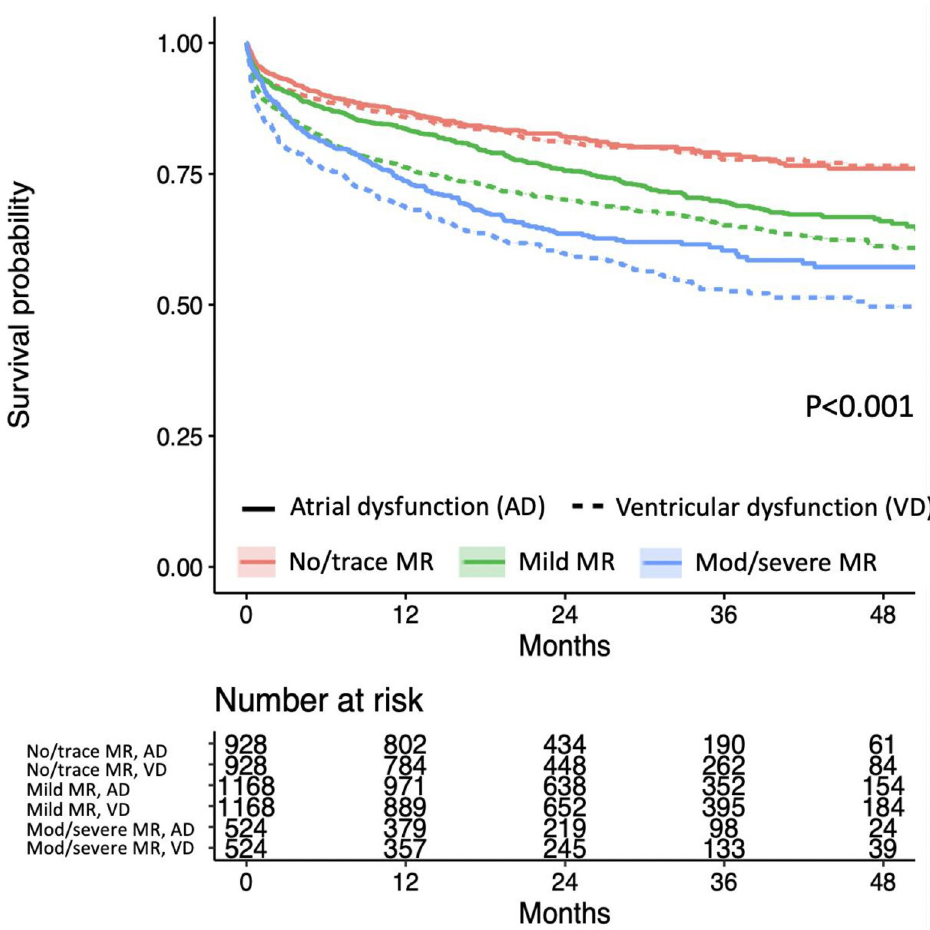
Fig 3. Matched group survival curves by different severities of mitral regurgitation. The figure shows Kaplan-Meier curves of patients with no or trace mitral regurgitation (MR) (red), mild MR (green), and moderate or severe MR (blue), stratified by patients with atrial dysfunction (solid) and patients with ventricular dysfunction (dotted) in the cohort matched by the propensity score and MR